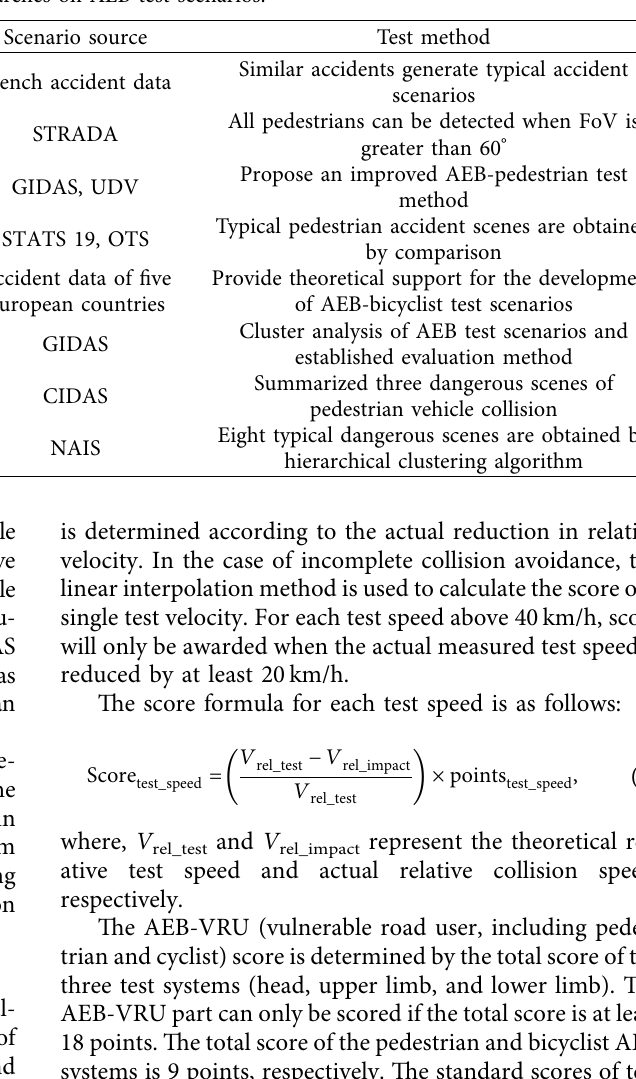
Table 4: Partly researches on AEB test